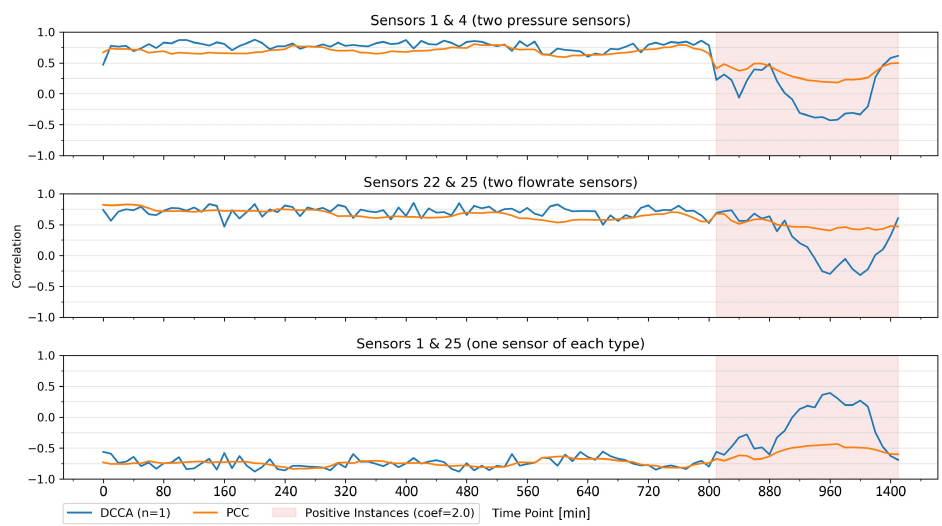
Figure 10. DCCA and PCC over time in three selected sensor pairs from chunk 702 using a time window of 40 time points.